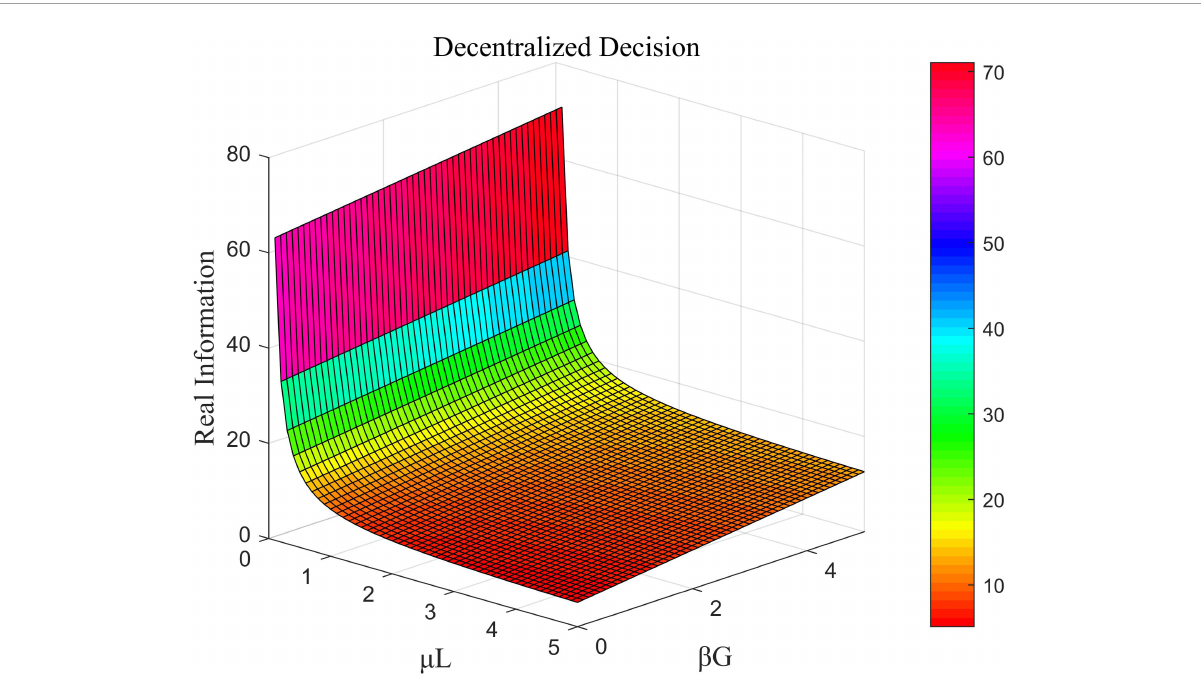
FIGURE6 Effects of µ L and β G on the total amount of real information under decentralized